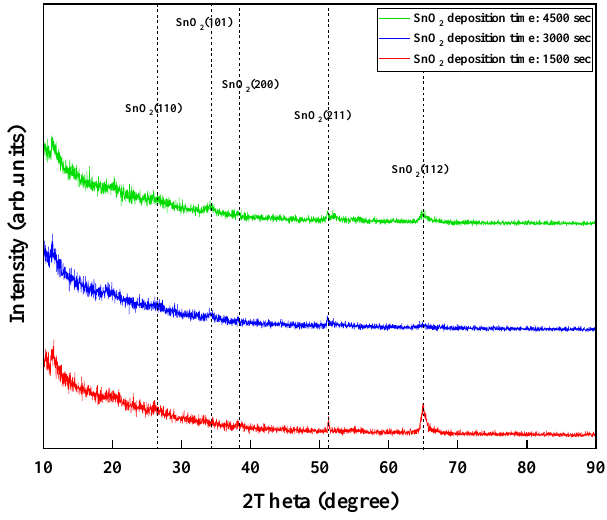
Figure 5. XRD patterns as a function of SnO 2 depositing